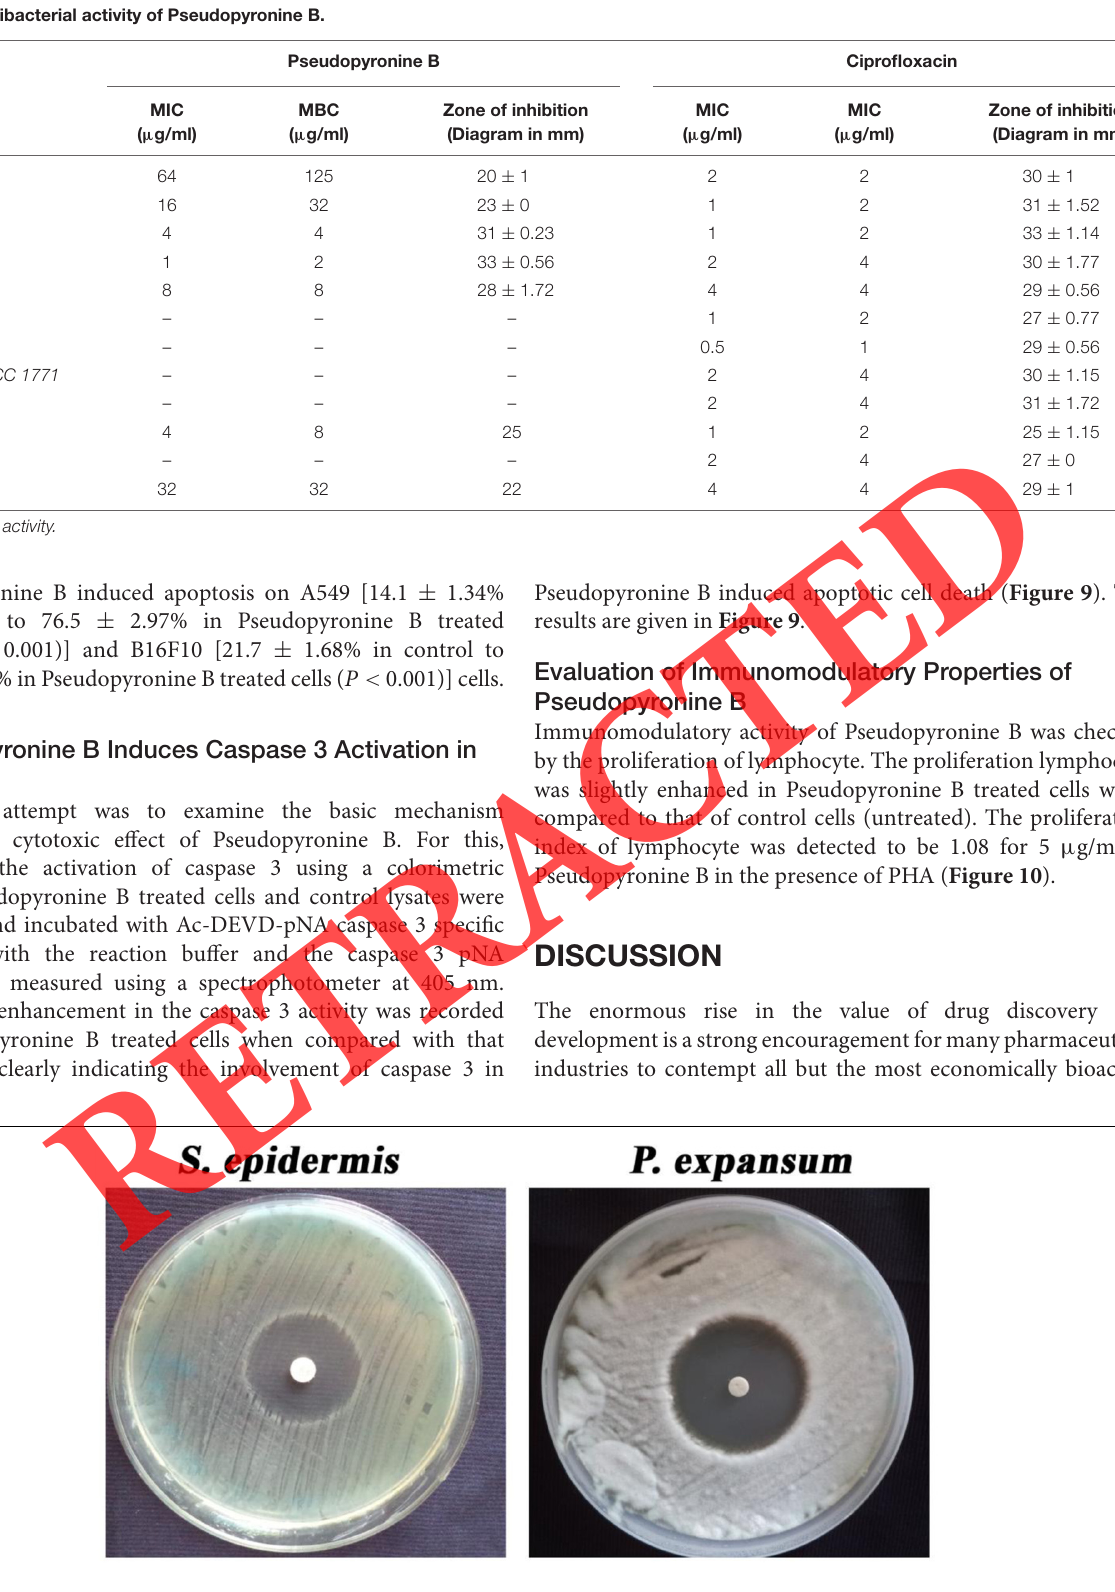
FIGURE 3 | Antimicrobial activity of Pseudopyronine